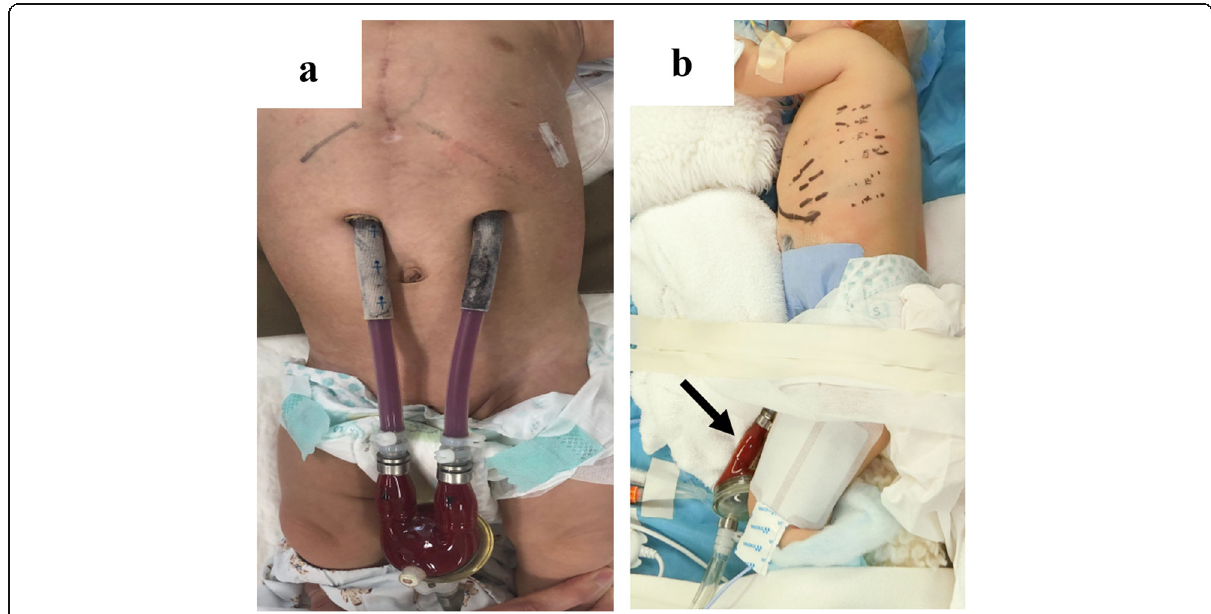
Fig. 2 Patient ’ s abdomen and position. a VAD cannulae were inserted from the upper abdomen. b She was placed in the right decubitus position. The blood pump (black arrow) and cannulae were fixed to her body